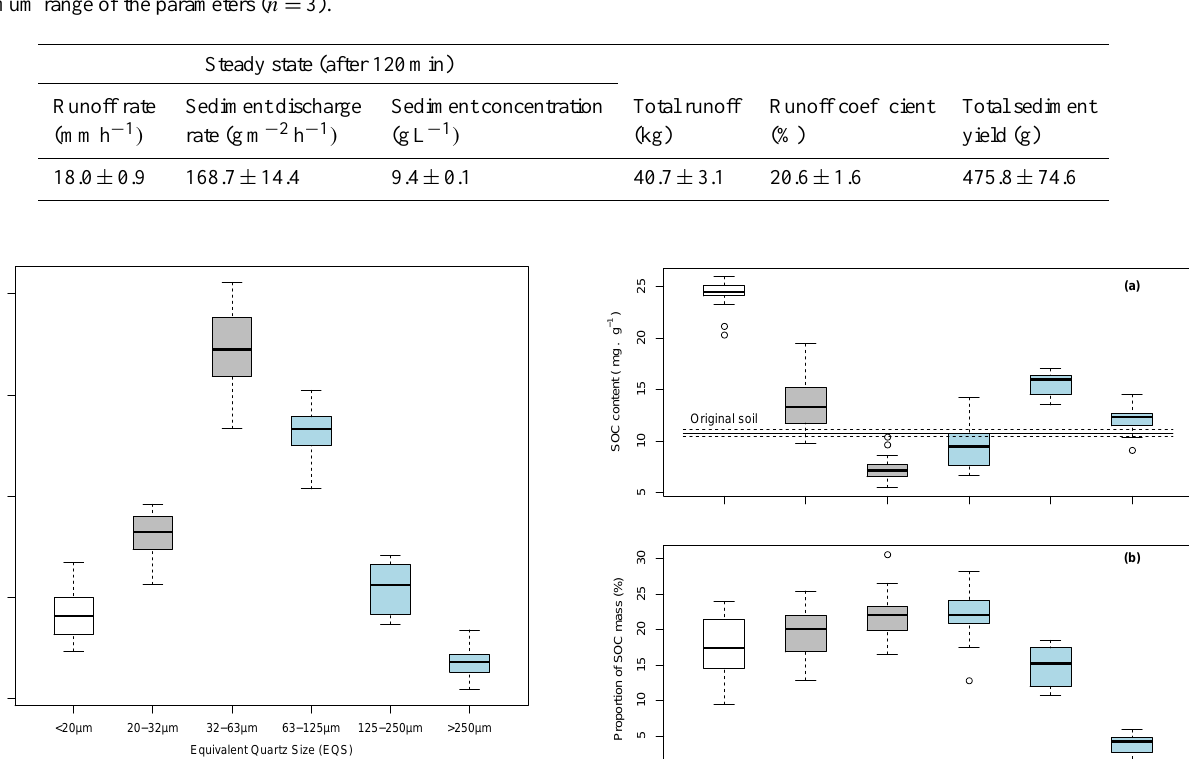
Table 3. Summary of the erosional responses of Möhlin soil over 180min of rainfall time. Subscripted numbers indicate the minimum and maximum range of the parameters ( n = 3).